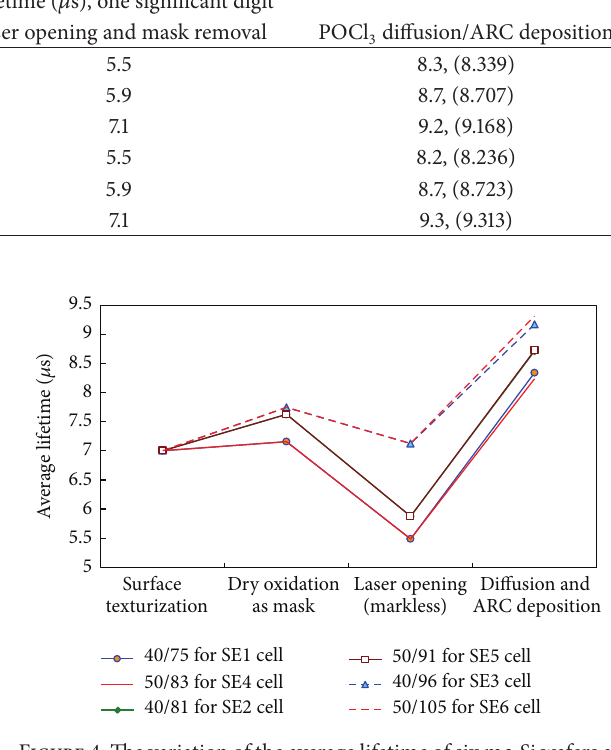
Figure 3: Variation of emitter sheet-resistances and thickness of barrier layer SiO 2 versus dry oxidation duration of six SE cells after one-step POCl 3 diffusion. The duration for SE1 and SE4 is 18 min, that for SE2 and SE5 is 25 min, and that for SE3 and SE6 is 35 min.